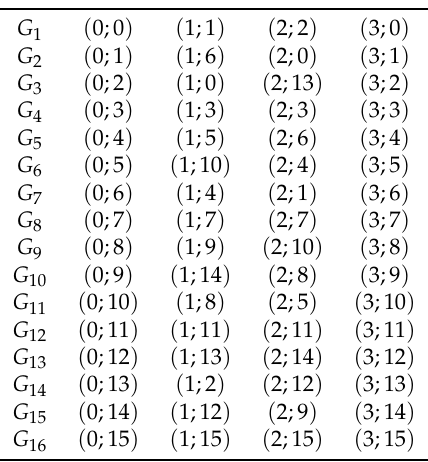
Table 1. Look-up table for 16-DQAM using proposed distance, L = 2.